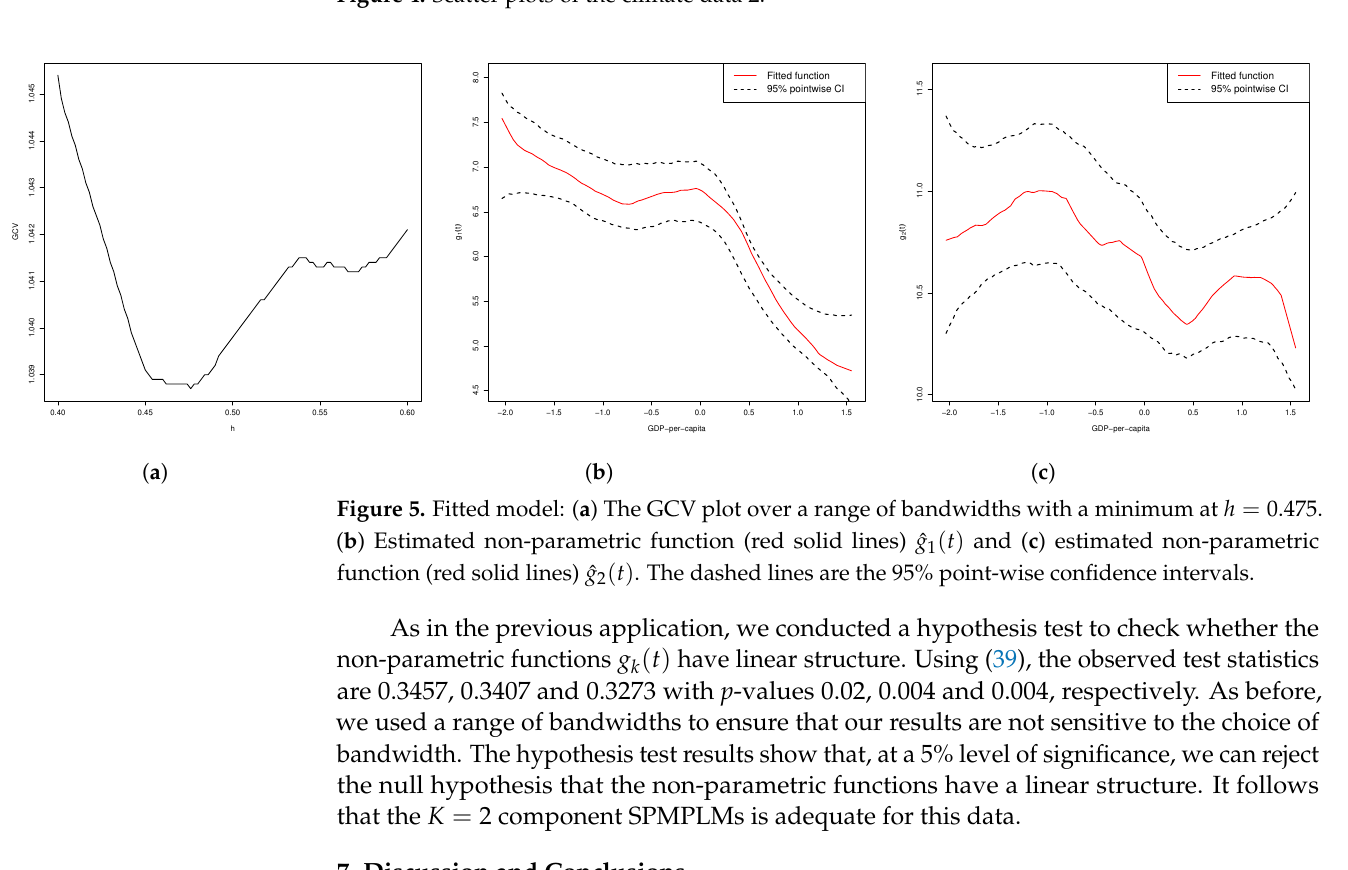
Figure 4. Scatter plots of the climate data 2.